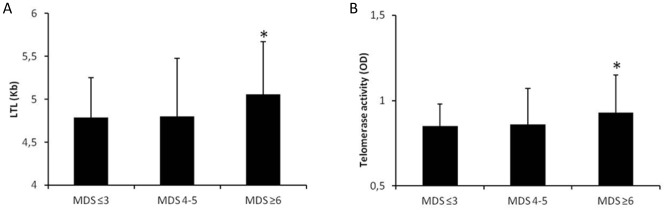
LTL and Telomerase Activity according Mediterranean Diet Score subgroups.Data are means ± standard deviation. MDS≤3: n = 70; MDS 4–5: n = 68; MDS≥6: n = 79. p values were obtained using ANOVA followed by Bonferroni multiple testing correction. A) *p = 0.003; MDS≥6 vs MDS≤3 p = 0.009 and MDS≥6 vs MDS 4–5 p = 0.011 B) *p = 0.013; MDS≥6 vs MDS≤3 p = 0.028 and MDS≥6 vs MDS 4–5 p = 0.033. LTL, Leukocyte Telomere Length; MDS, Mediterranean Diet Score.